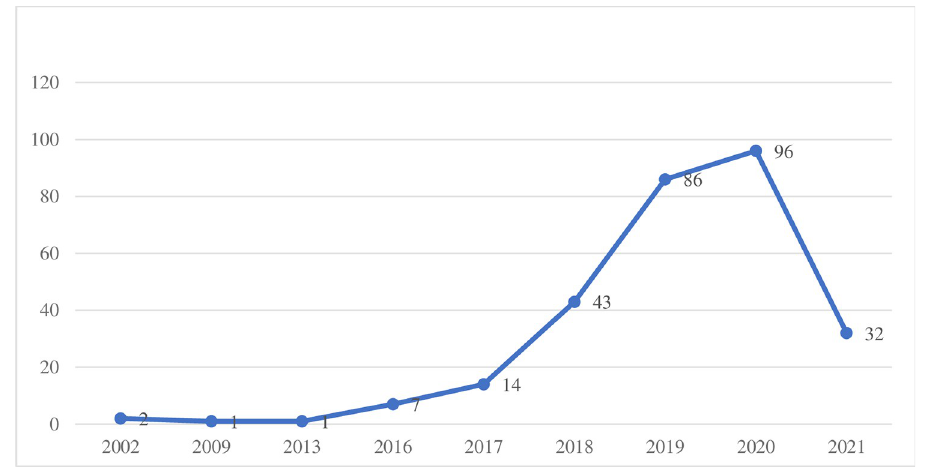
Fig 2. Final dataset publications per